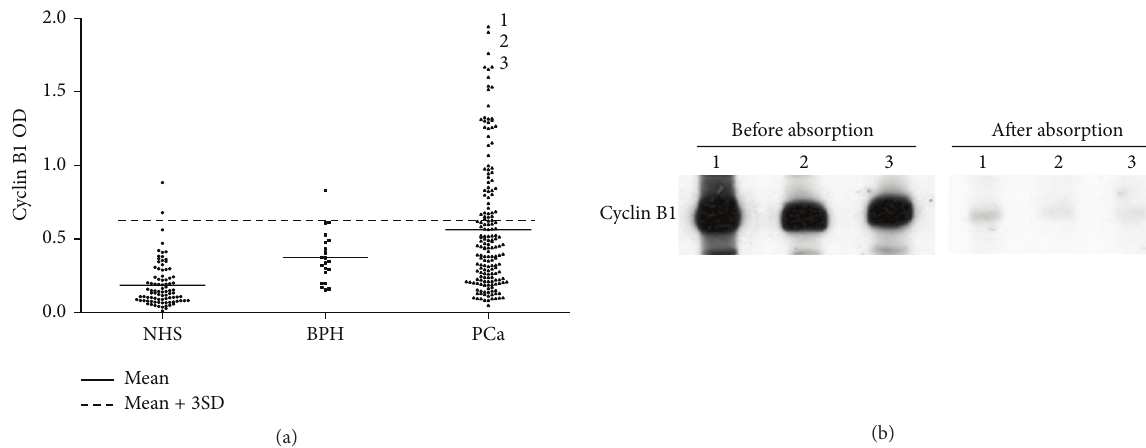
Figure 1: (a) Antibody titers to cyclin B1 in ELISA were expressed as optical density (OD) units. The mean + 3SD of normal human sera are shown in relationship to PCa and BPH. (b) Western blotting analysis shows antibody reactivity to cyclin B1 before and after absorption in nitrocellulose membrane strips blotted with purified recombinant cyclin B1 protein. Lanes 1–3 are sera from PCa patients and the corresponding OD values of these sera are indicated in panel (a). In general, OD values in ELISA were related to intensity of signals in Western blotting and the signals decreased obviously after sera